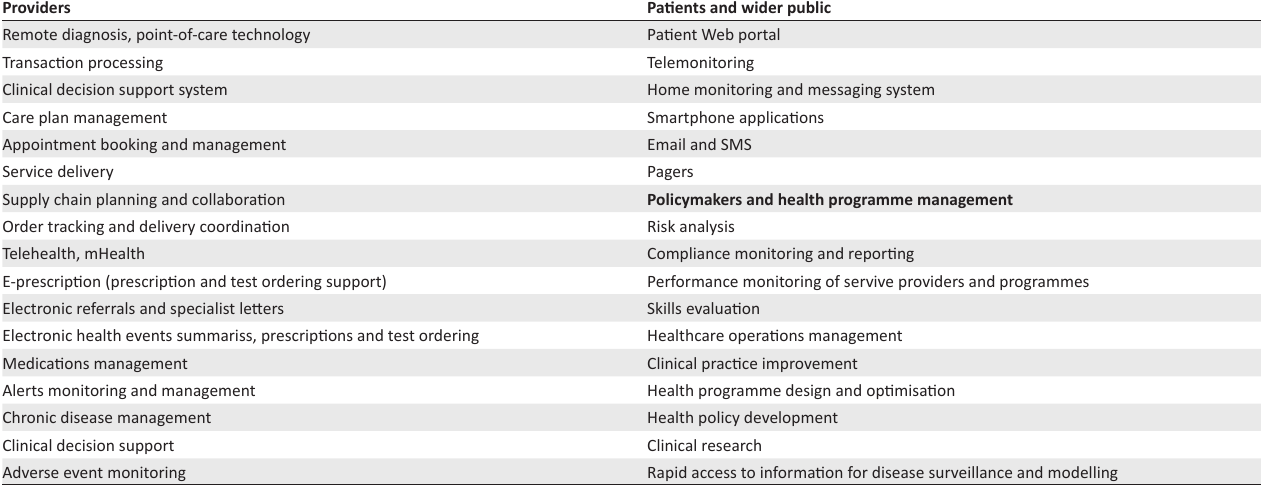
TABLE 3: Disease management delivery tools and support tools for